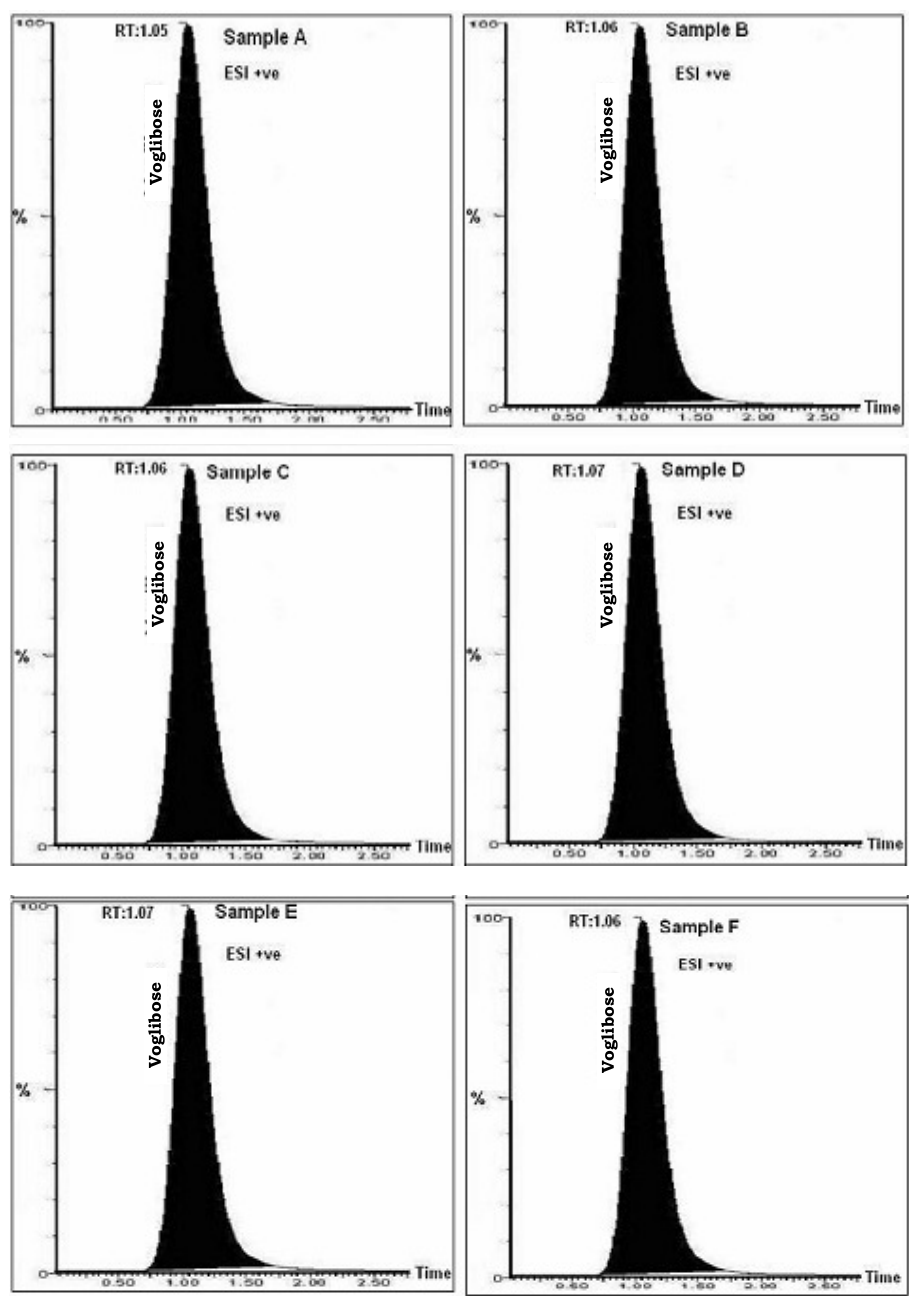
Figure 4. LC-MS/MS chromatogram of six formulations of voglibose (A to